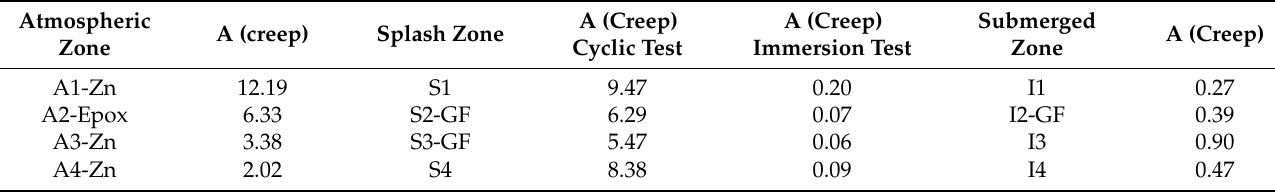
Table 11. Acceleration factors for all